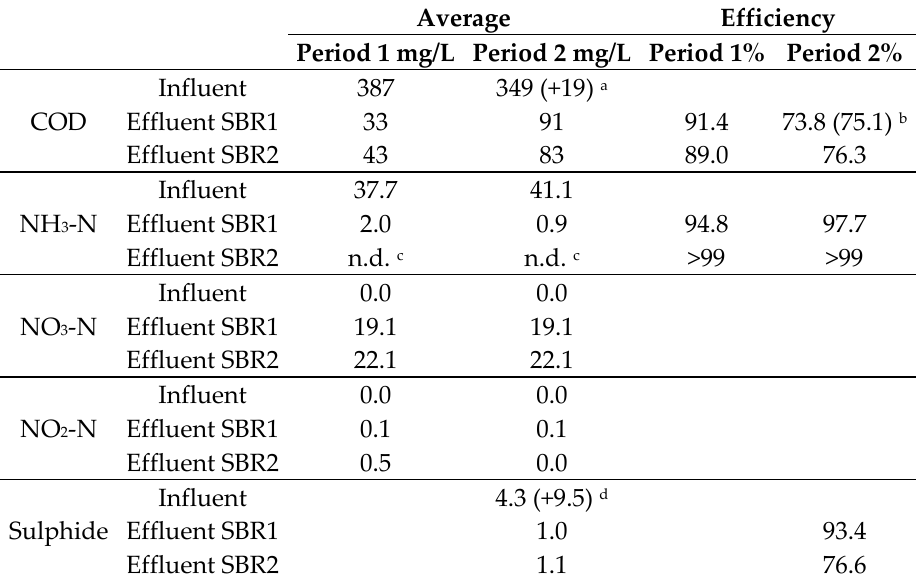
Table 1. Average concentrations and removal efficiencies of the main process